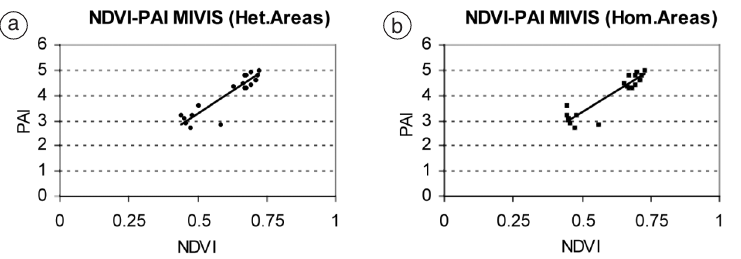
Fig. 5a,b. Linear relationships between NDVI values, calculated on the basis of the MIVIS image, and PAI val- ues measured in the field. The coefficient of determination ( R 2 ) is equal to 0.83 for both a) heterogeneous ( y = 6.8851 x − 0.1451); and b) homogeneous areas ( y = 6.5625 x + 0.0563).